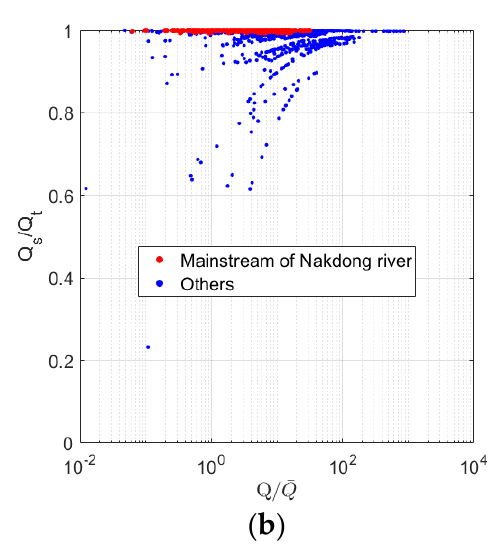
data from equal-discharge-increment method (EDI) and the equal-width-increment method (EWI). (EWI).